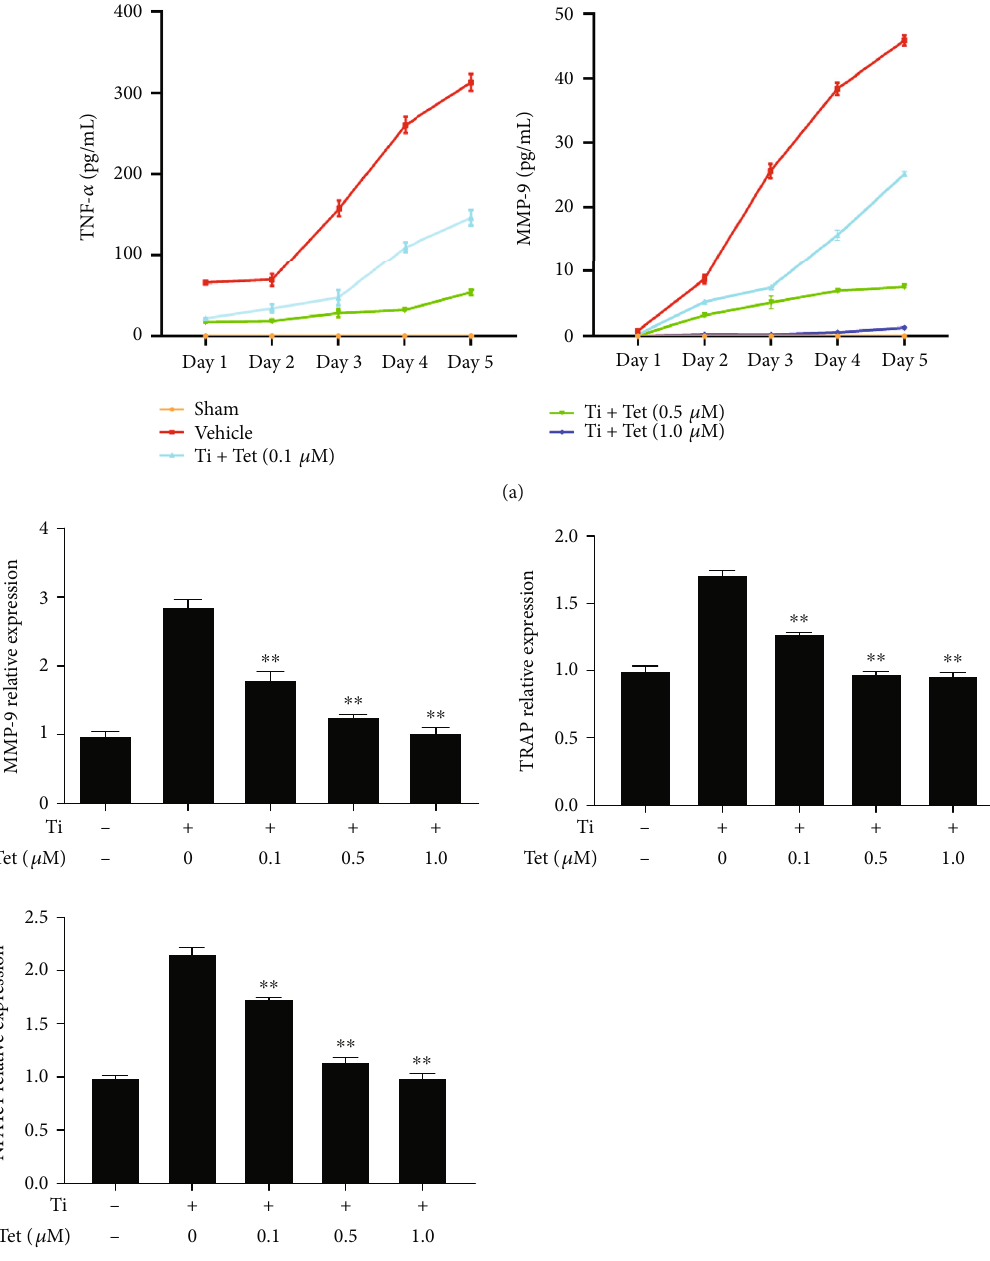
Figure 6: Tetrandrine (Tet) reduces the expression of osteoclast-related genes (including nuclear factor of activated T-cells, cytoplasmic 1 (NFATc1), tartrate-resistant acid phosphatase (TRAP), tumor necrosis factor (TNF)- α , and matrix metallopeptidase (MMP)-9). (a) TNF- α and MMP-9 secretion in the supernatant of the RAW264.7 cell culture medium in each group on days 1 – 5. (b) MMP-9 , TRAP , and NFATc1 mRNA expression in each group on day 5 ( ∗ p < 0 : 05 , ∗∗ p < 0 : 01 compared with the control group; n = 3 per group). Data are the means of at least three independent experiments with similar